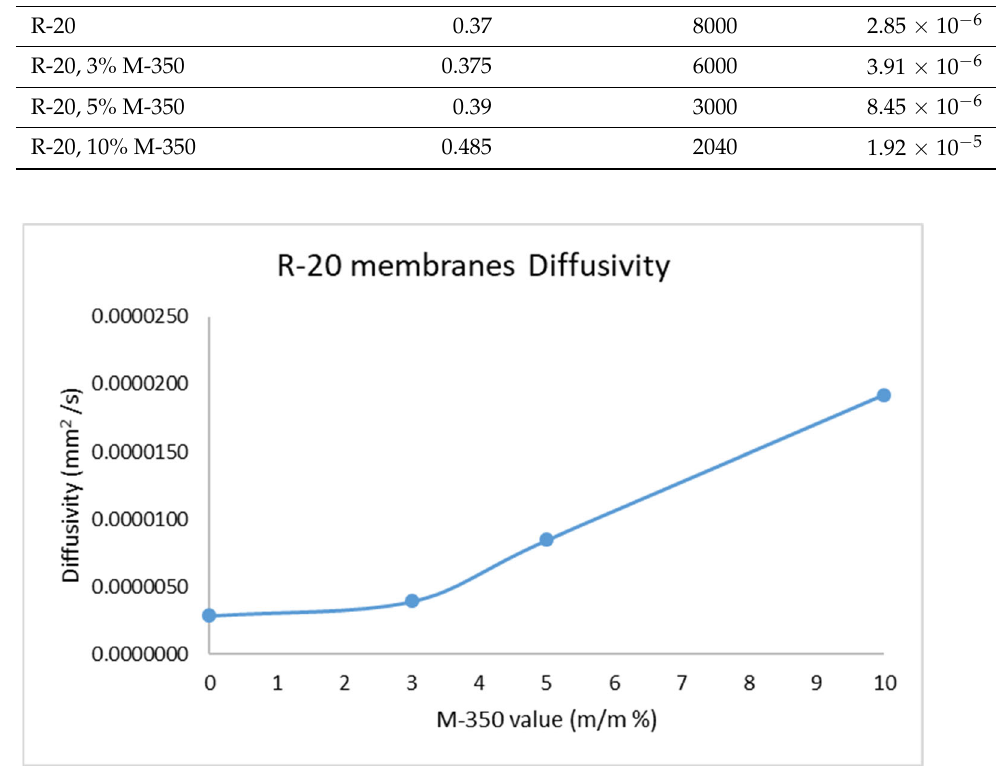
Figure 3. Effect of filler value on the DADS diffusivity through the silicone membranes.